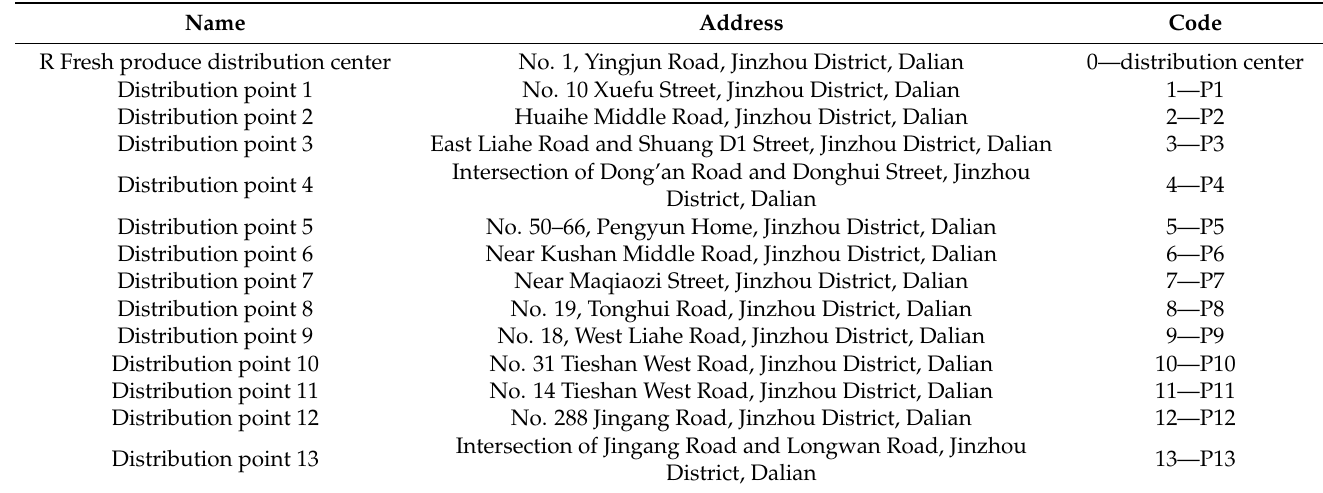
Table 3. Distribution point address and code.